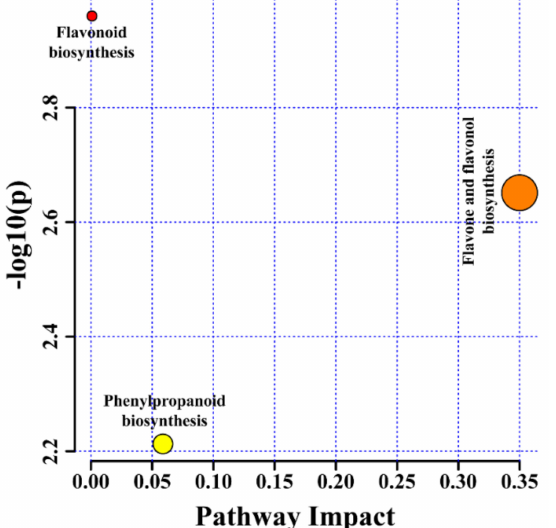
Figure 6. Identified metabolites and their pathway impact on different root cultures of F. tataricum